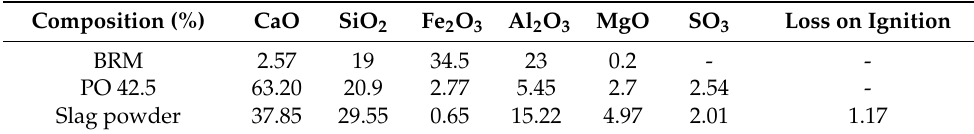
Table 1. Chemical composition of different backfilling